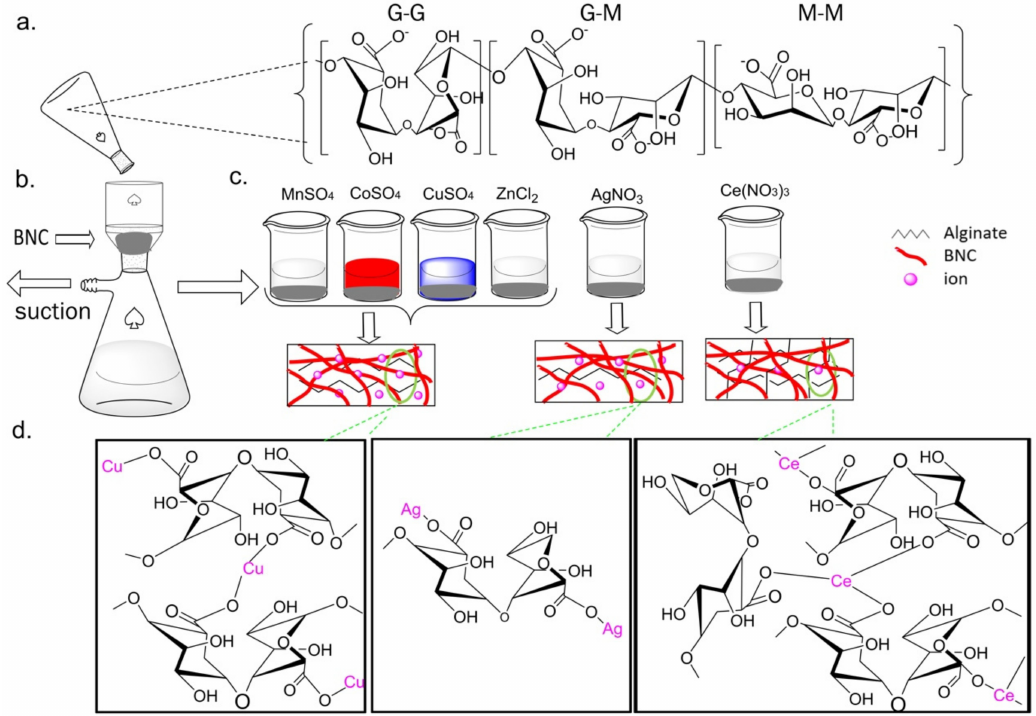
di ff erent salt solutions; ( d ): Formation of the composite hydrogels by coordination of di ff erent cations between adjacent alginate chains as per the “egg-box”